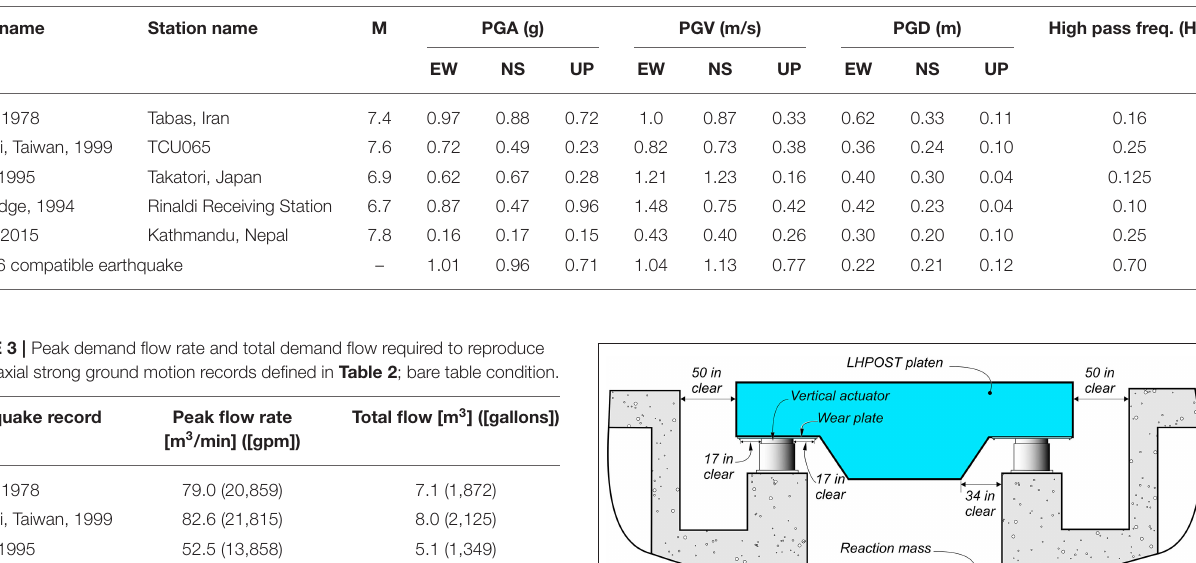
TABLE 2 | Tri-axial strong ground motion records considered for the preliminary design of the LHPOST6.